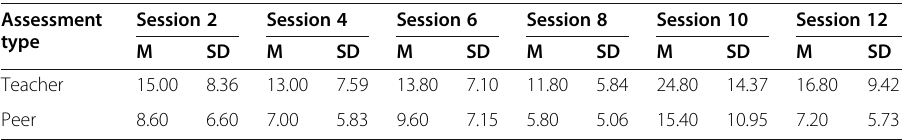
Table 6 Descriptive statistics of TA and PA on narrative writings Assessment type